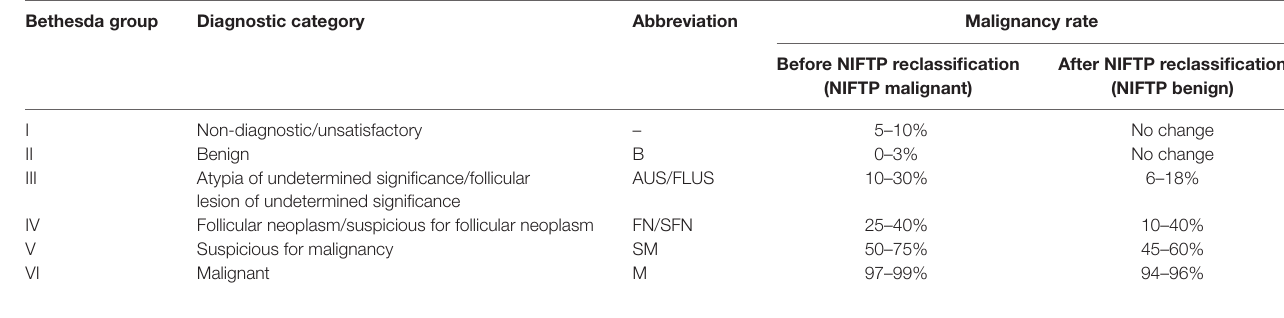
TAble 1 | The Bethesda system for reporting thyroid cytopathology